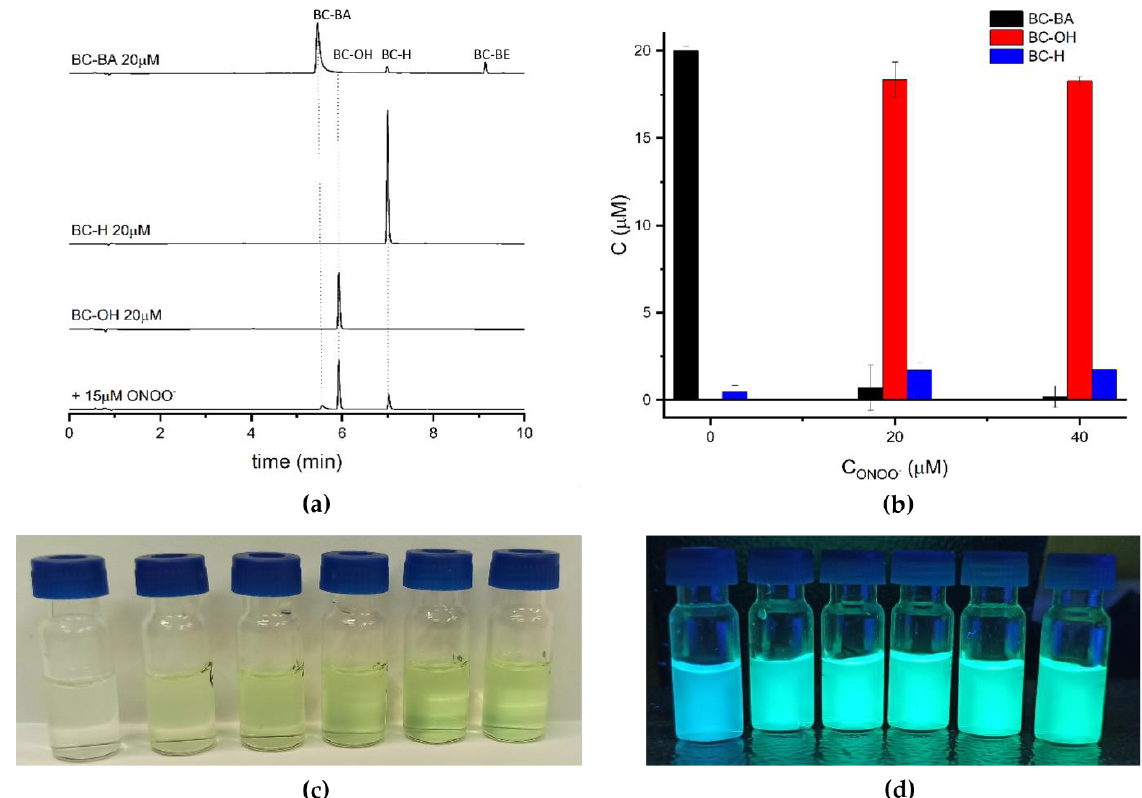
Figure 3. Peroxynitrite-induced oxidation of the BC-BA probe. ( a ) HPLC traces of the mixture of BC-BA , BC-OH , and BC-H (20 µ M each) and the reaction mixtures of BC-BA (20 µ M) with peroxynitrite (15 µ M) after 5 min of incubation. Tests were conducted in aqueous solutions containing EtOH (10%), phosphate buffer (0.1 M, pH 7.4) and dtpa (10 µ M). The traces were collected using an absorption detector set at 330 nm; ( b ) HPLC based titration of BC-BA probe (20 µ M) with ONOO – (0–40 µ M). Pictures of BC-BA probe (20 µ M) with different amount of peroxynitrite (0, 6, 12, 18, 24, 30 µ M): ( c ) in day light; ( d ) under UV.